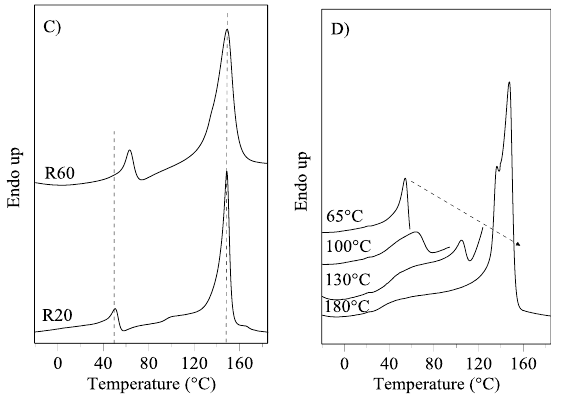
Figure 3. DSC curves of PBTF stretched film: ( A ) I and II scan (20 °C/min); ( B ) untreated and annealed (10 min at the indicated temperatures) stretched film; ( C ) different heating rates (20 and 60 °C/min, dotted lines represent eye guides); ( D ) consecutive heating steps to 65, 100, 130 and 180 °C.